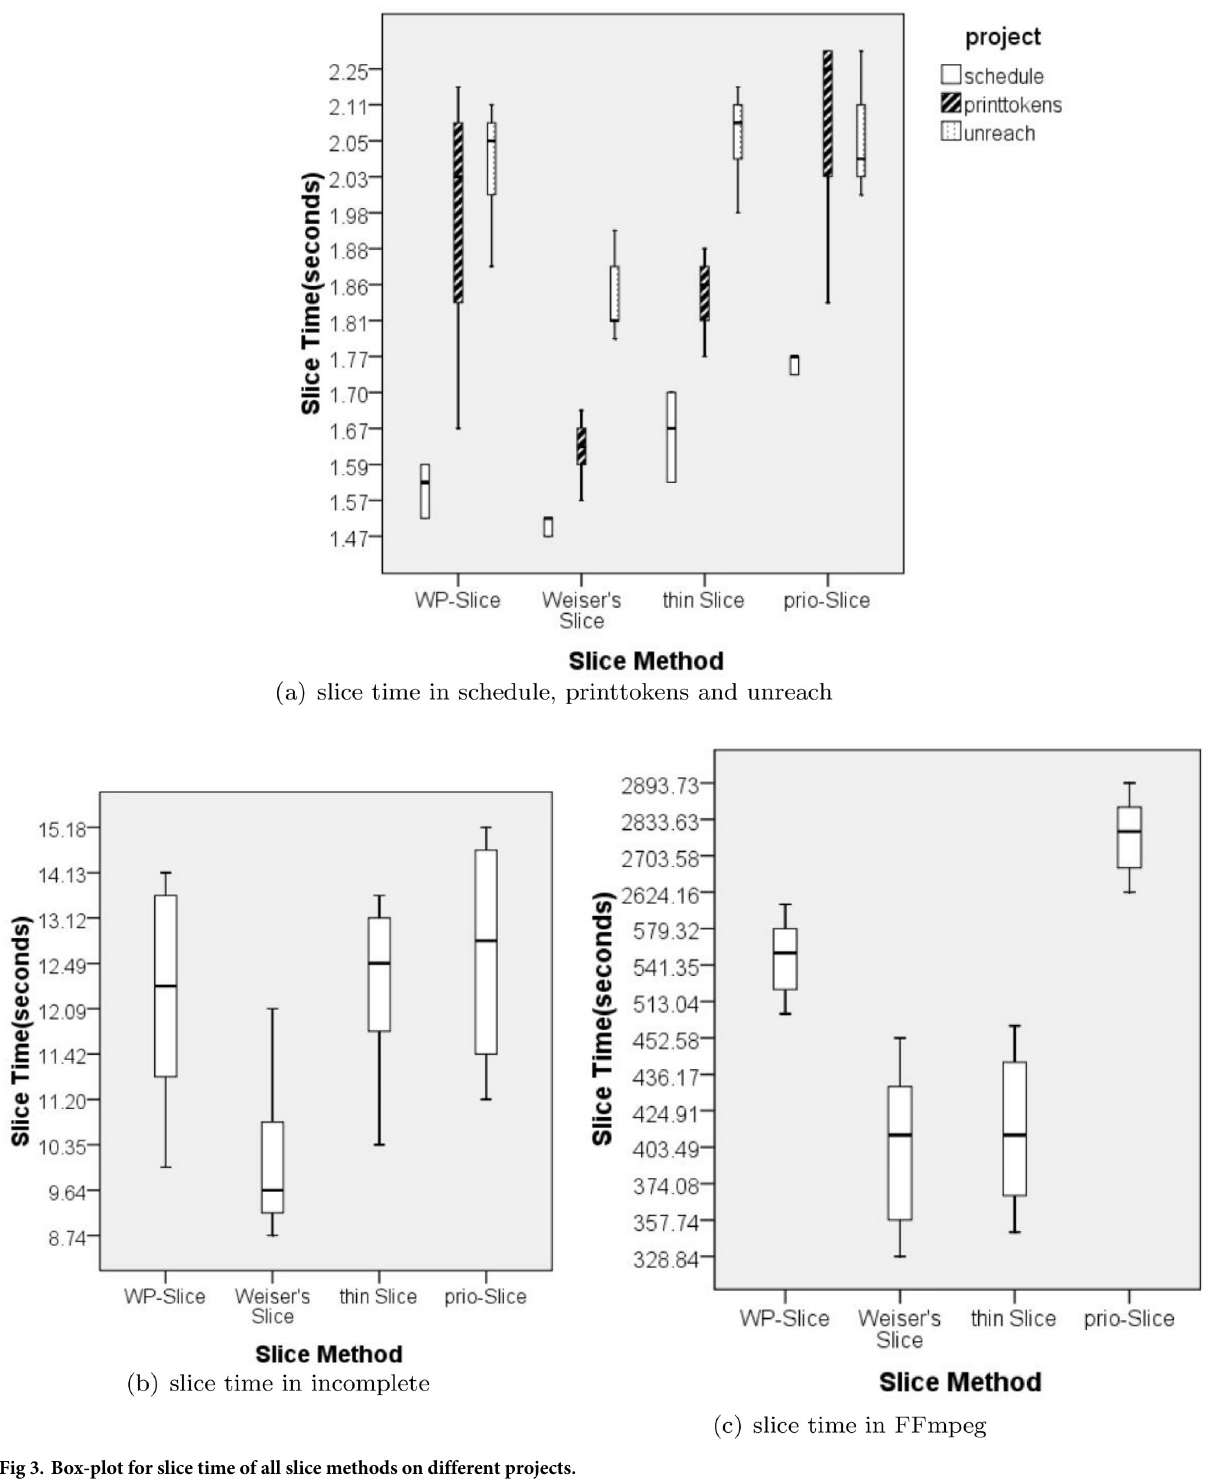
Fig 3. Box-plot for slice time of all slice methods on different projects.